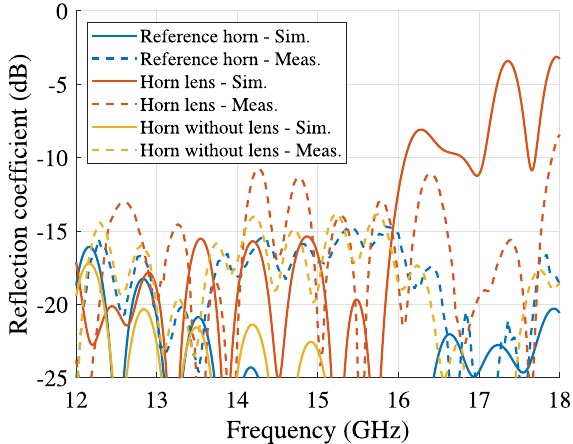
Figure 9. Simulated and measured reflection coefficients for the horn lens antenna, profiled horn antenna without lens, and the reference antenna. The dimensions are L L = L H = 207 mm, W L = W H = 167 mm, H L = H H = 20 mm, and F L = 40 mm .